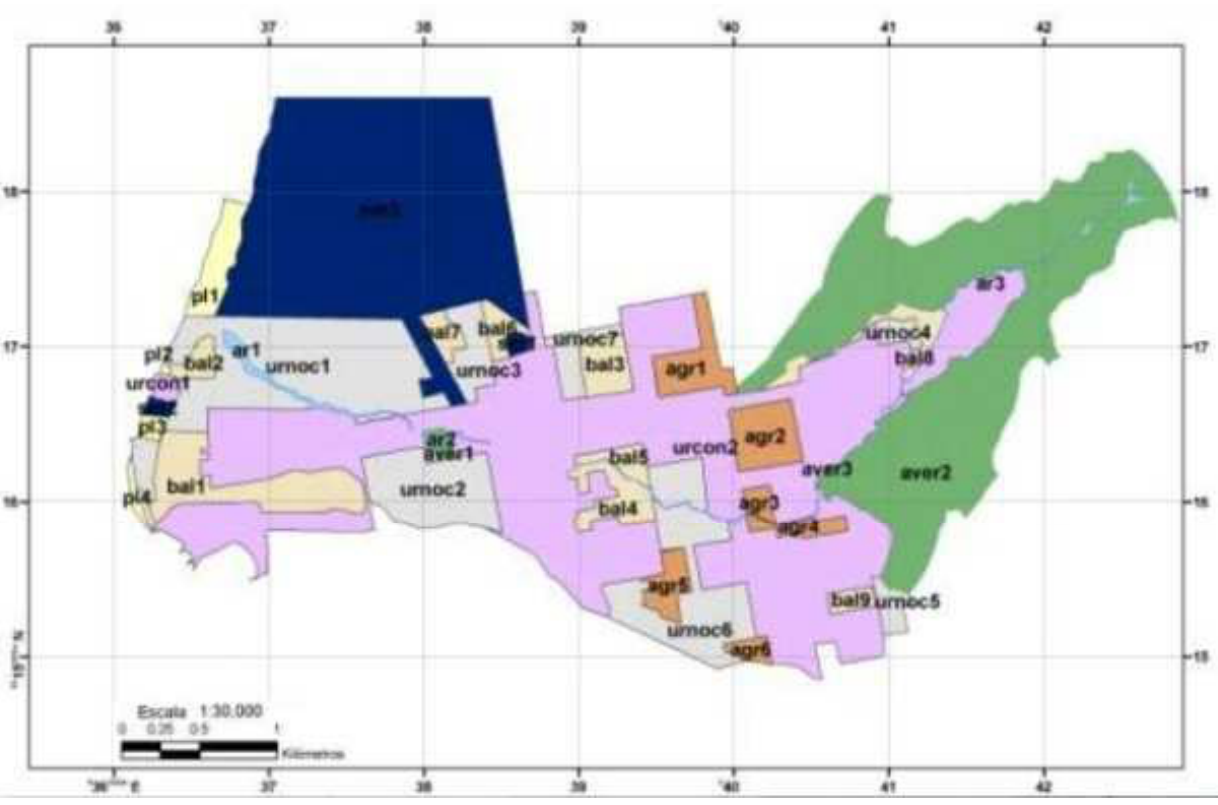
Fig. 6. El Campillo eroded temporal river (taken from MEZA-UABC 2010).